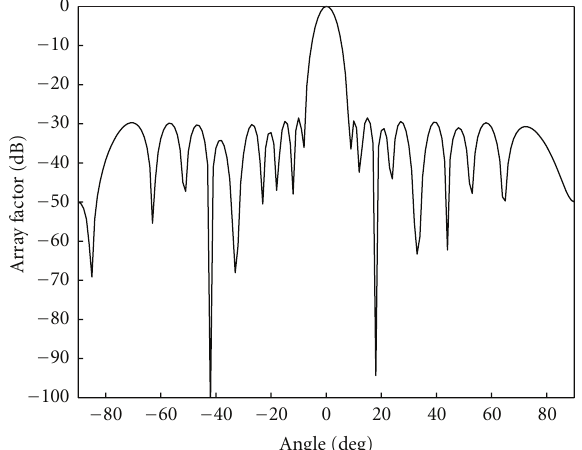
Figure 6: Radiation pattern for 3rd and 18th element failure with main beam at − 30 ◦ . Dotted line curve shows the damaged array pattern and the solid line curve shows the corrected pattern.